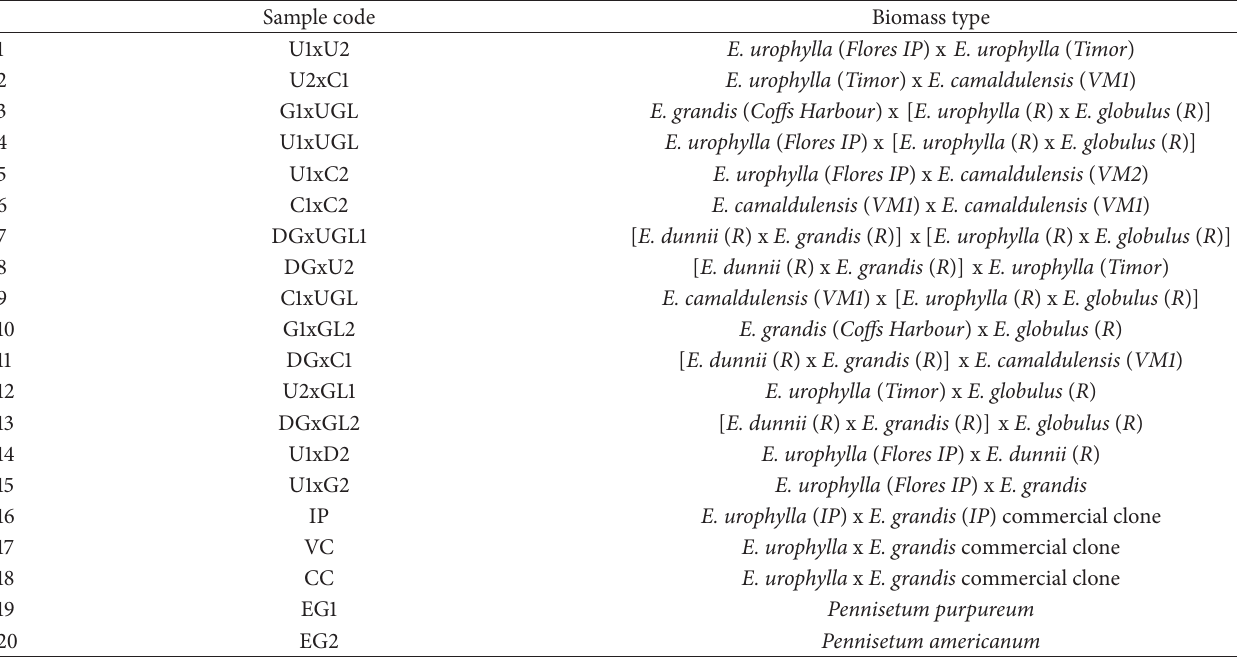
Table 1: Codification of the eucalypt clones and elephant grass